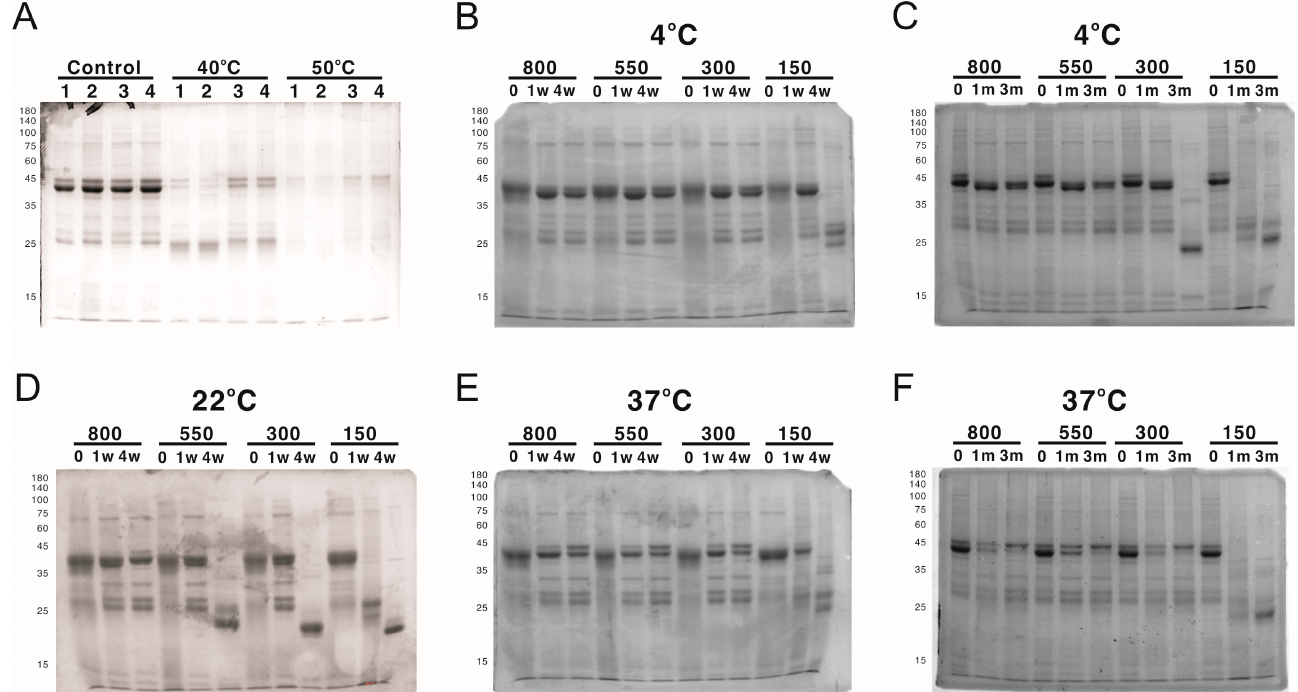
Figure 7. The analysis of protein nanoparticle stability using SDS-PAGE. The protein nanoparticle stability was analyzed by both SDS-PAGE and DLS. ( A ) Protein samples of 1) AH3–sfGFP–2xhM2e, 2) LY-sfGFP–2xhM2e, 3) RRLE–sfGFP–2xhM2e, or 4) LYRRLE–sfGFP–2xhM2e were incubated at